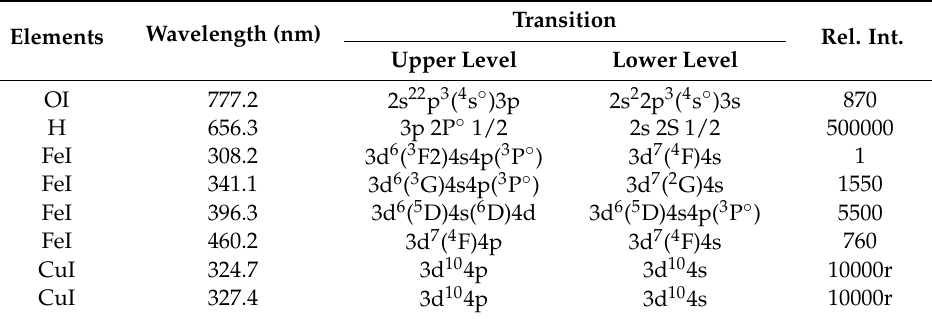
Table 3. The characteristic peaks of the main element.